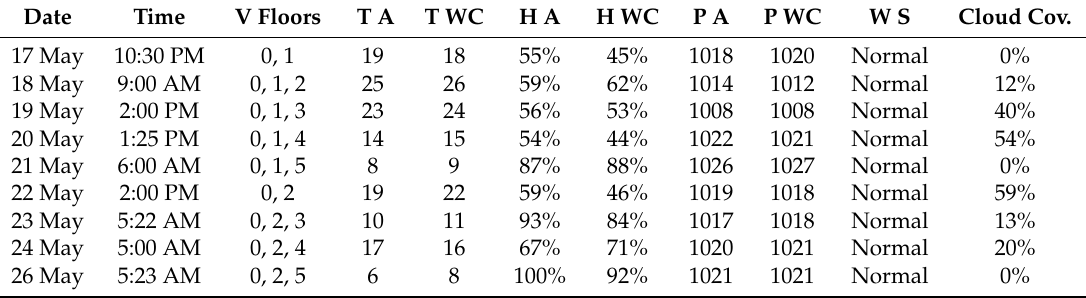
Table A2. Collected data used for evaluation of Building B. The table shows the data acquisition date, the time, the visited floors (V Floors), the indicated temperature from AccuWeather (T A) and the Weather Channel (T WC), the humidity from the same two sources (H A) and (H WC), the ambient pressure from AccuWeather (P A) and from the Weather Channel (P WC), the walking speed (W S) and the cloud